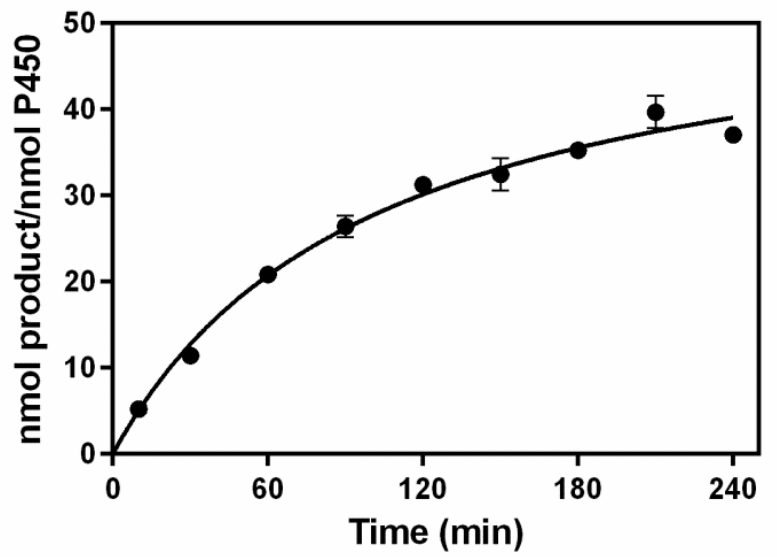
Figure 6. Total turnover numbers (TTNs) for OA hydroxylation by CYP3A4. The TTNs by CYP3A4 were measured by HPLC after the reaction at 37 °C during the indicated time of 10 – 240 min. The reaction mixture included 0.2 µM of CYP3A4, an NADPH regeneration system, and 0.5 mM of substrate in final volume of 0.25 mL in potassium phosphate buffer (100 mM, pH 7.4).